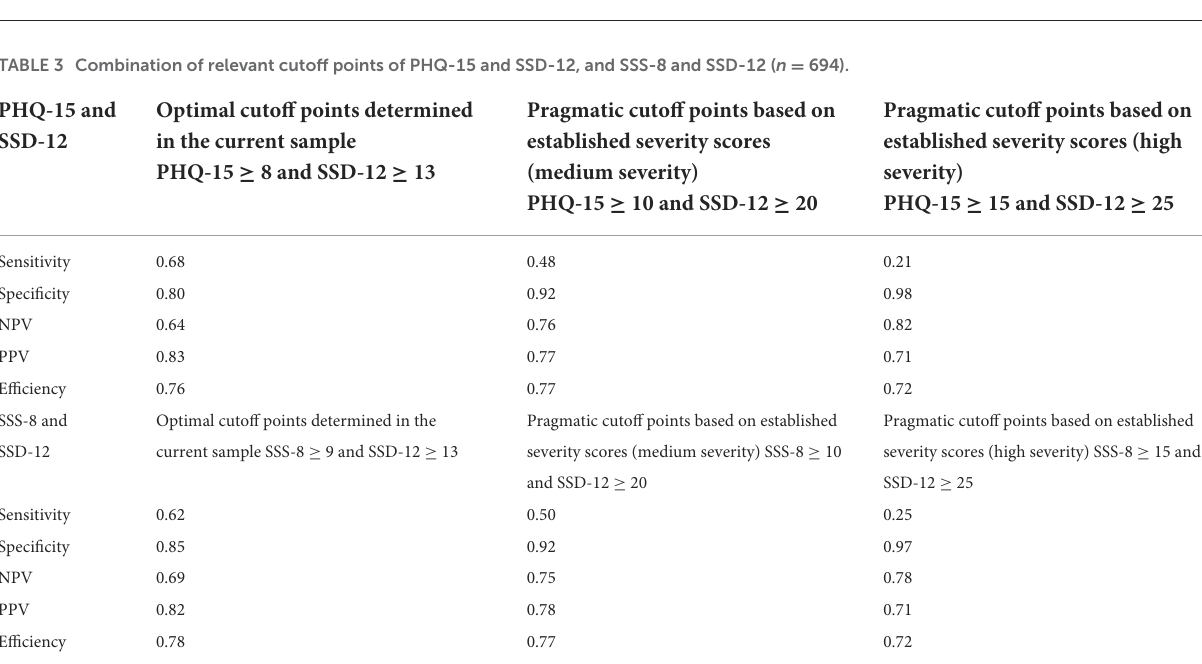
FIGURE1 ROC curves of PHQ-15, SSS-8, SSD-12, WI-8, and their combinations.